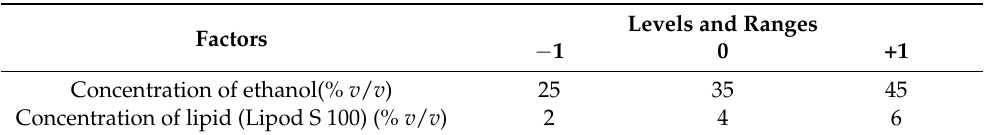
Table 3. Different factors and their ranges in Design Expert software with constraints for dependent variables.